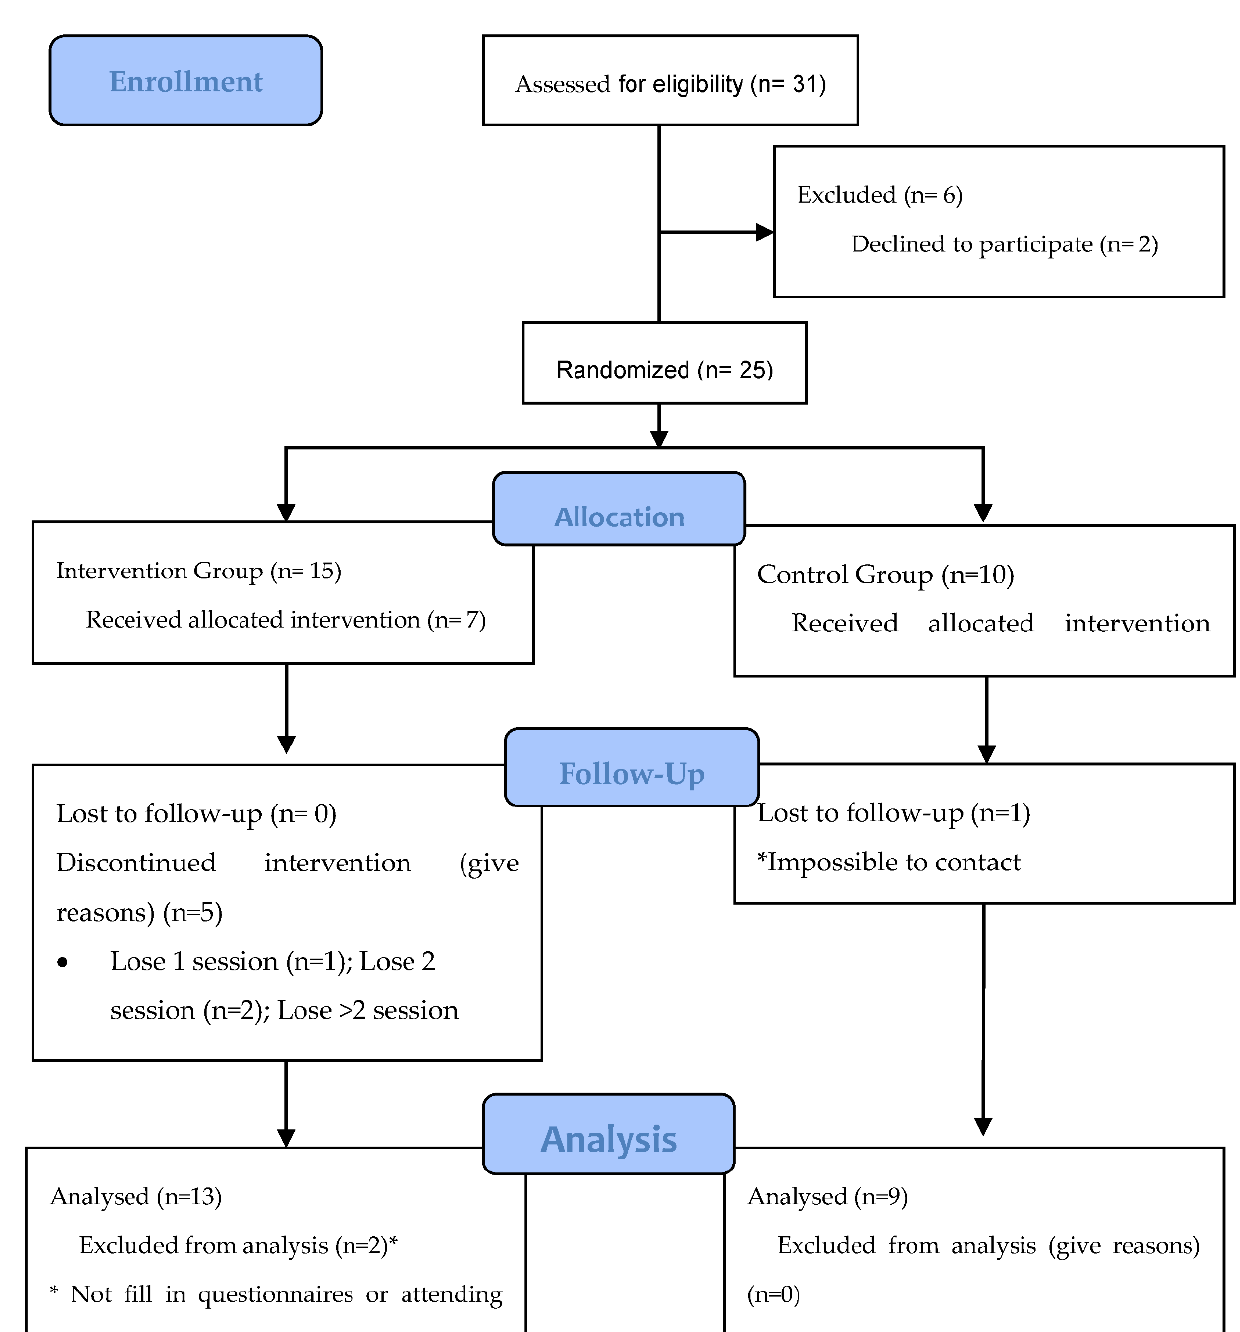
Figure 1. Study participation flow. * Reason for losses. Table 1. Participants socio-demographic characteristics.